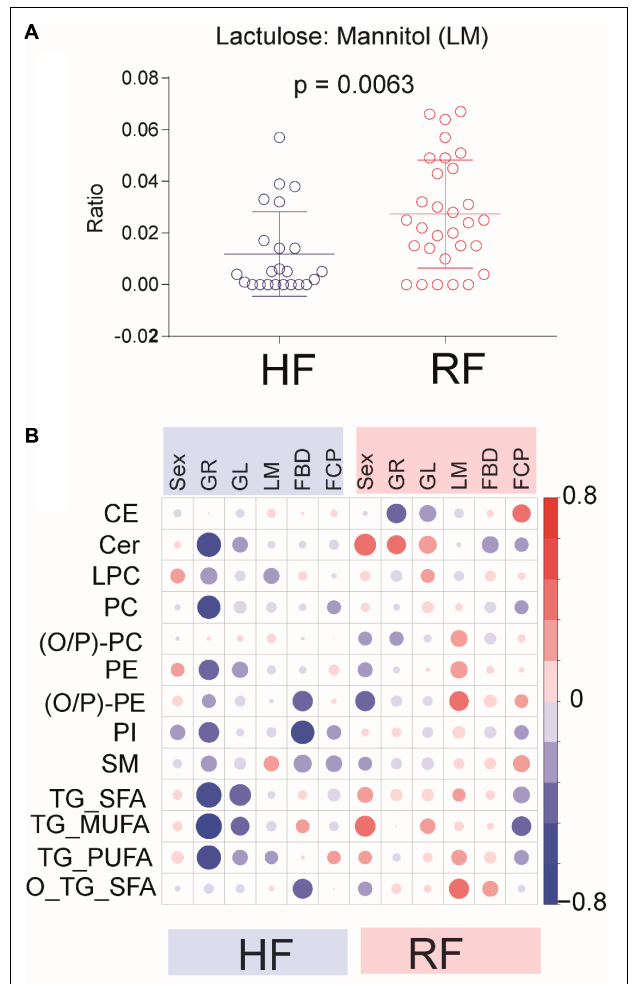
FIGURE 3 | Associations between serum lipids and gastrointestinal markers in the infants. (A) Comparison of lactulose mannitol ratio between HF vs. RF infants at 9 months of age. (B) Pairwise Spearman correlations as calculated between serum lipids and offspring gut inflammation marker and permeability. Here, FBD stands for fecal beta-defensin and FCP for fecal calprotectin. Correlations were calculated between simultaneous measurements at 9 months of age. Positive correlations marked in red, inverse correlations marked in blue. Dot size for each pairwise correlation corresponds to the strength of the calculated